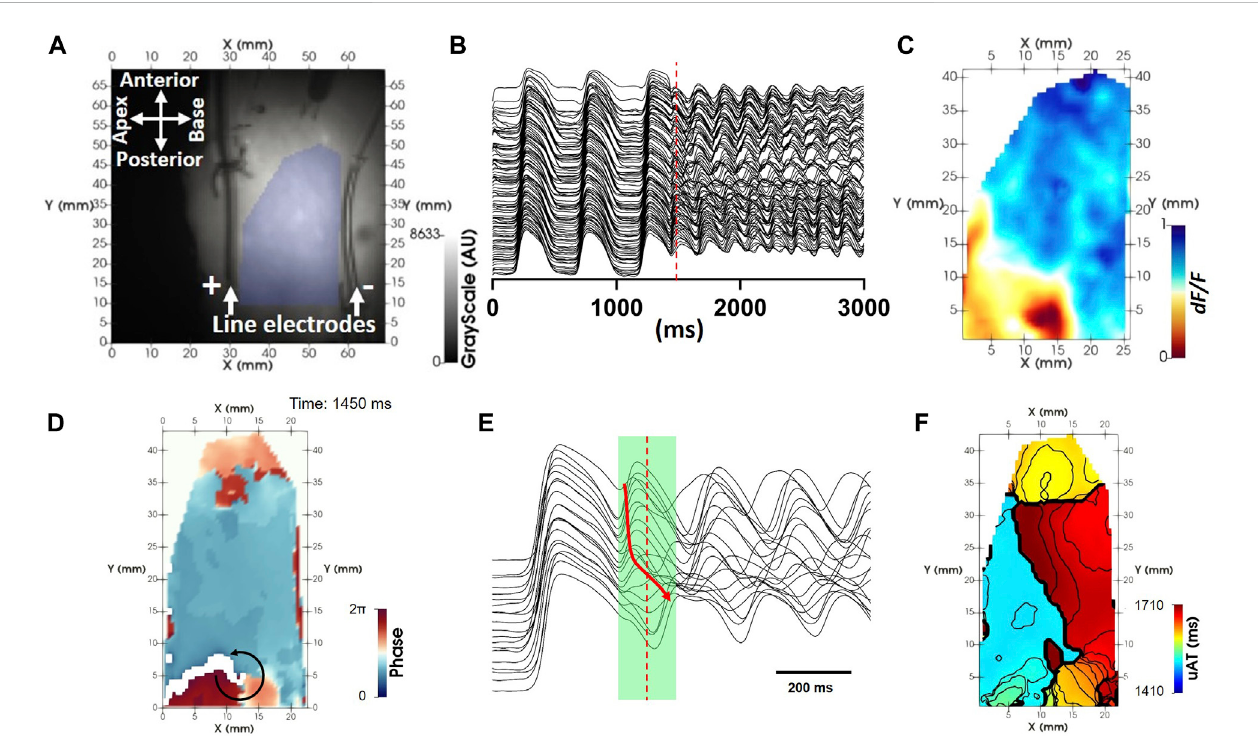
FIGURE 1 uAT mapping extracted from a fi xed time window during reentry. (A) Background optical mapping image of the endocardial surface from a coronary- perfused right ventricle. The region of interest lying in between two line electrodes for reentry induction is highlighted by blue shading. (B) Example pre- processed optical mapping signals extracted from the full region of interest. (C) A snapshot of the dynamic voltage-dependent optical signal ( F/dF ) during reentry [time indicated by the red dashed line in (B) ]. (D) An instantaneous phase map derived using the Hilbert transform showing evidence for a repetitive propagating wave front [red dashed line in (B) ]. (E) Example pre-processed optical mapping signals extracted from pixels along the circular black arrowin (D) .AgreenshadedregionindicatesauniformtimewindowusedtoderiveuATpointsusingtheuniformwindowmethodforcalculationofactivation time. The red arrow shows the principle sequence of activation. (F) uAT map corresponding to the fi xed time window shown in B during reentry. Isolines are spaced 10